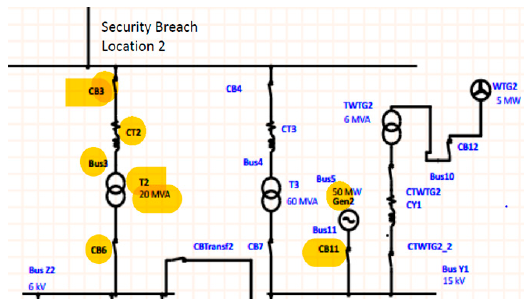
Figure 11. Security breach—Location 2.